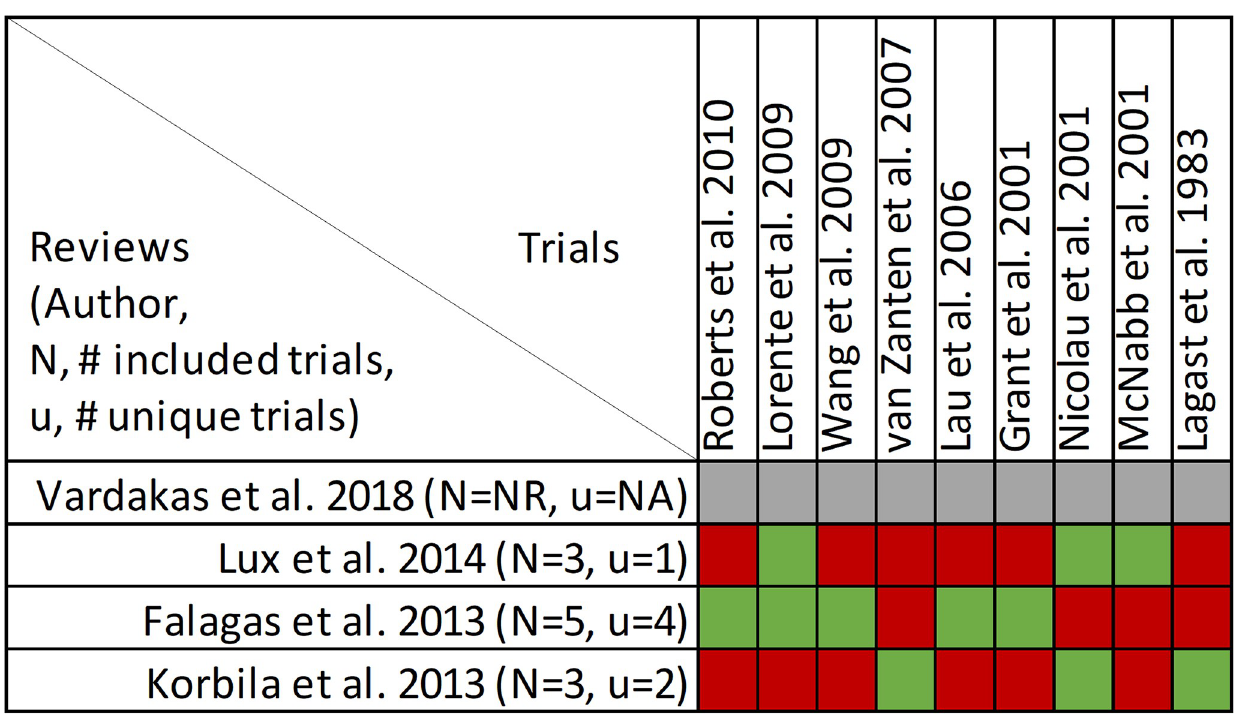
Fig 18. Citation matrix for reviews reporting emergence of resistance of prolonged versus intermittent infusion of beta-lactams. Green—primary studies included in systematic review, Red—primary study not included in systematic review, Black—primary studies published after systematic review and therefore ineligible for possible inclusion, Grey—included primary studies not reported for the specified